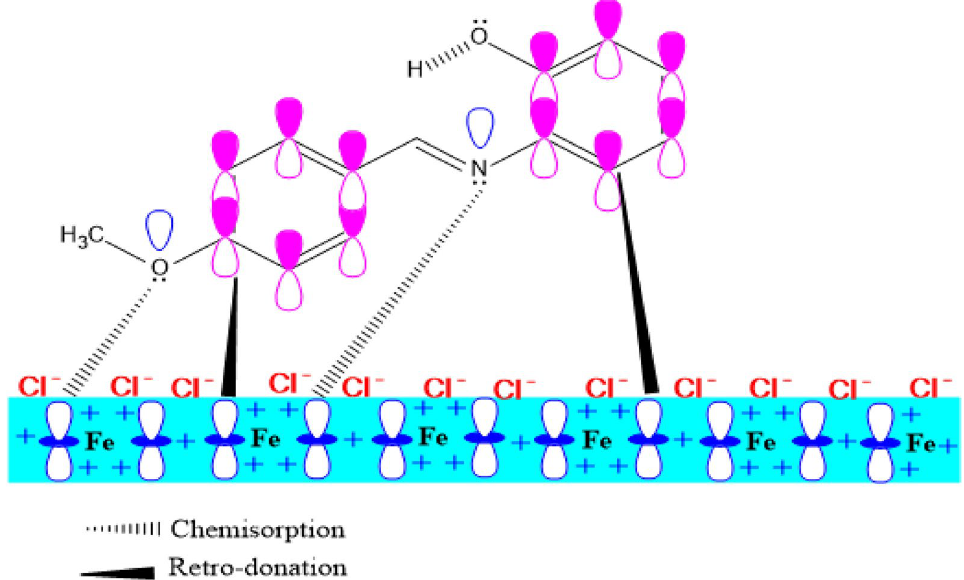
Figure 9. Schematic representation of the adsorption mechanism of inhibitors on the Fe (1 1 0) surface in 0.1 M